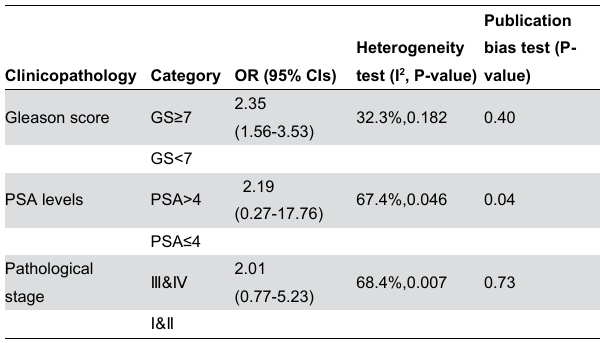
3. between RASSF1A promoter methylation and Pathological stage, Gleason score, and PSA levels in PCa